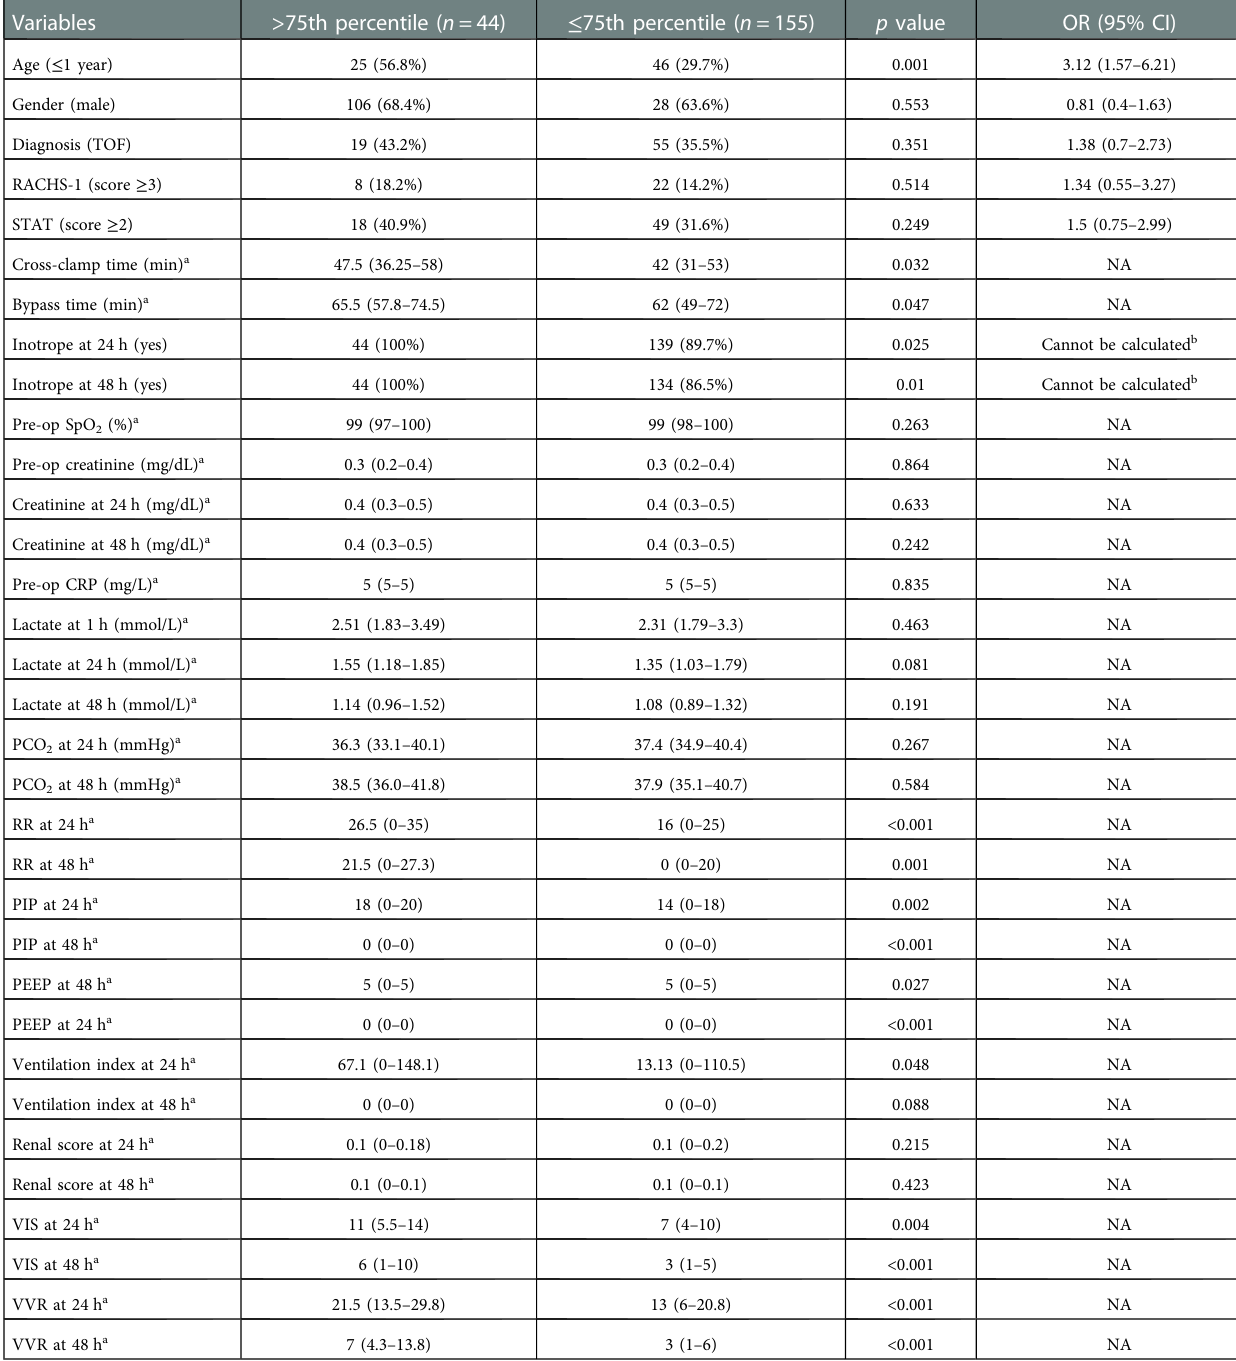
TABLE 2 Univariate analysis showing factors associated with prolonged length of hospital stay (>9